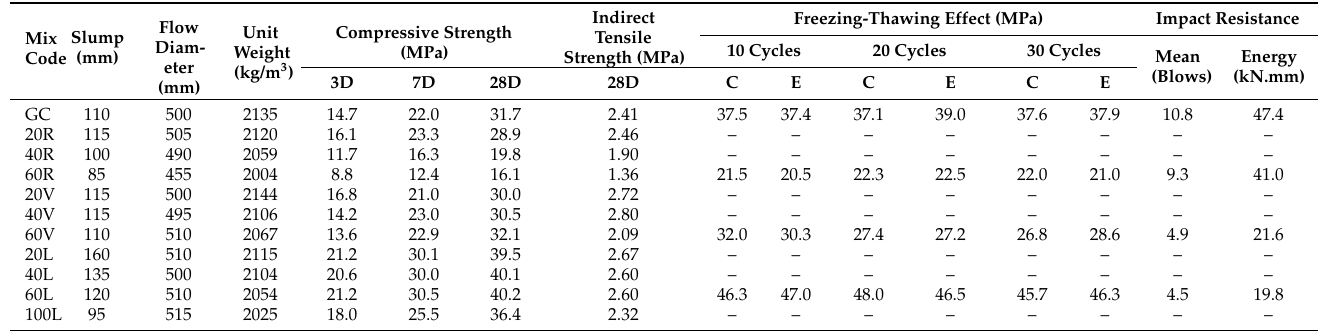
Table 3. Experimental